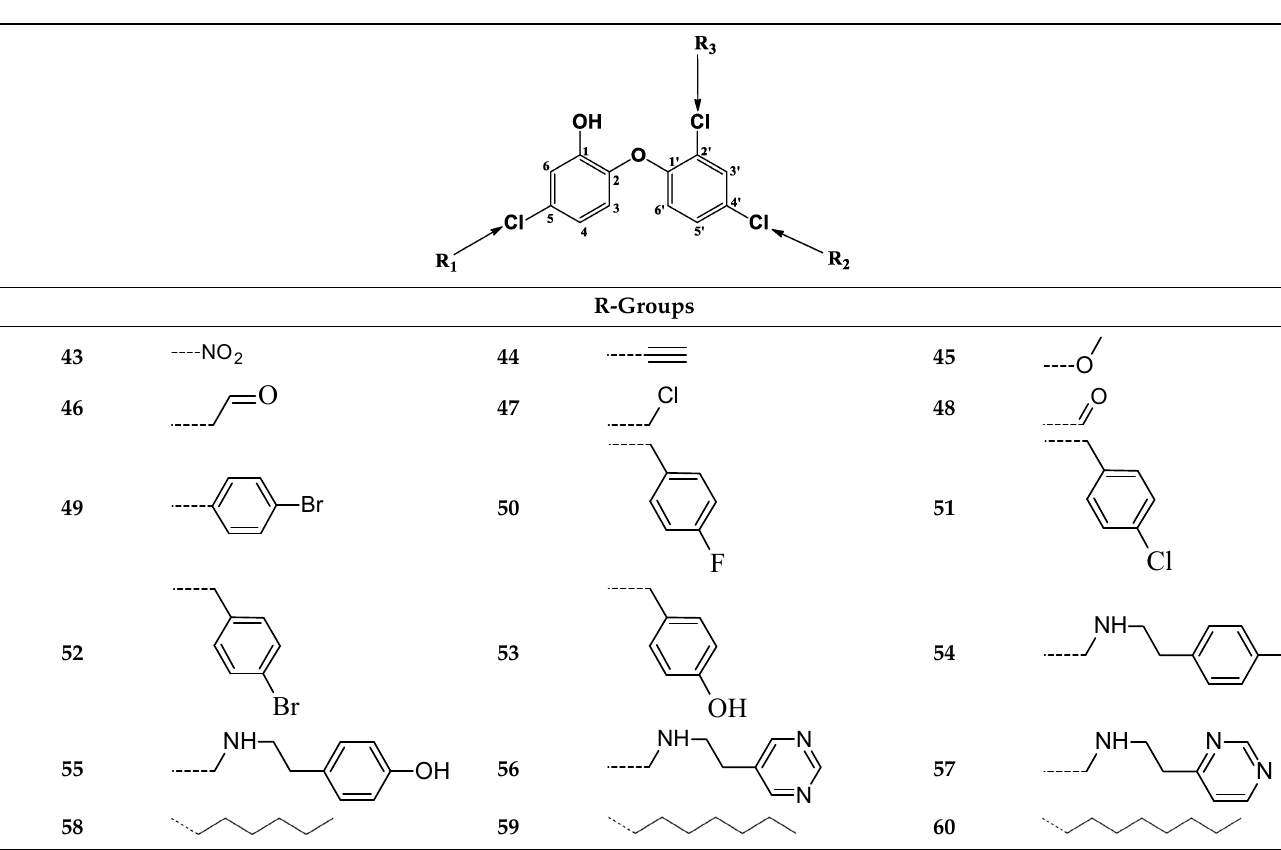
Table 5. R (cid:2869) , R (cid:2870) and R (cid:2871) groups used in the design of the initial diversity library of TCL analogues.